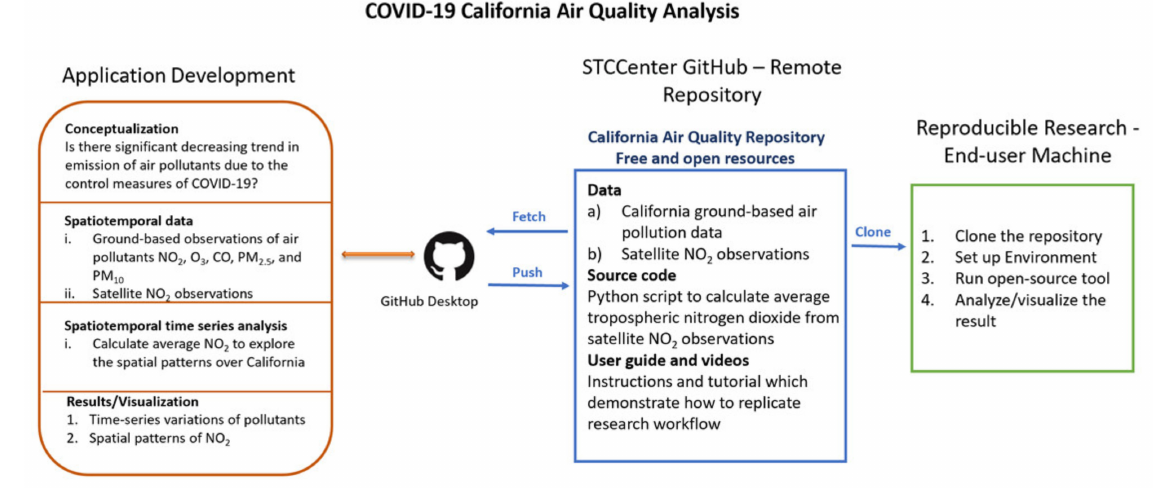
Figure 2. Spatiotemporal open-source workflow for COVID-19 California Air Quality